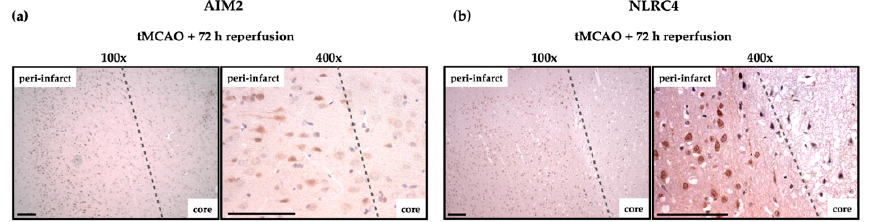
Figure A2. AIM2 and NLRC4 IHC staining of the late time point of 72 h reperfusion.